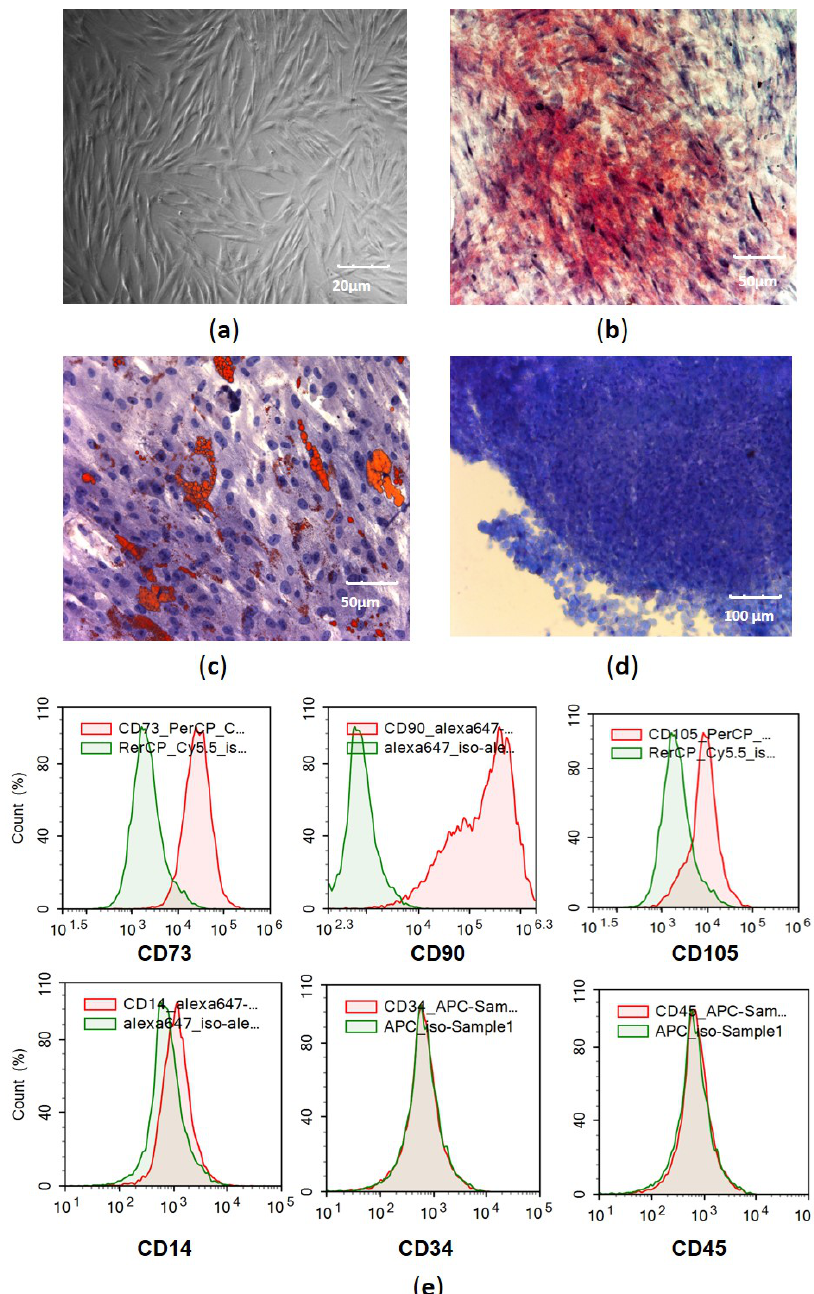
Figure 1. Morphology, phenotype, and multilineage differentiation potential of adipose-derived MSCs. ( a ) Phase contrast image shows fibroblast-like morphology of MSCs from adhesion culture of second passage; ( b ) accumulation of mineralized matrix in MSCs, with alizarin red staining; ( c ) accumulation of adipose vacuoles in MSCs, with Oil Red O and hematoxylin staining; ( d ) toluidine blue staining of mucopolysaccharide extracellular matrix in cryosections from MSC micromass pellets cultured in chondrogenic media; and ( e ) flow fluorometry of MSCs stained with antibodies to surface markers CD90, CD73, CD105 CD34, CD45, and CD14 conjugated with Alexa Fluor 647, APC, and Per-CP-Cy5.5, with green indicating isotype control and red indicating specific surface markers.